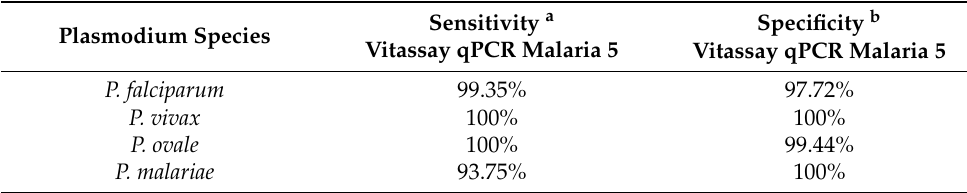
Table 4. Sensitivity and specificity of the Vitassay qPCR Malaria 5 for each Plasmodium